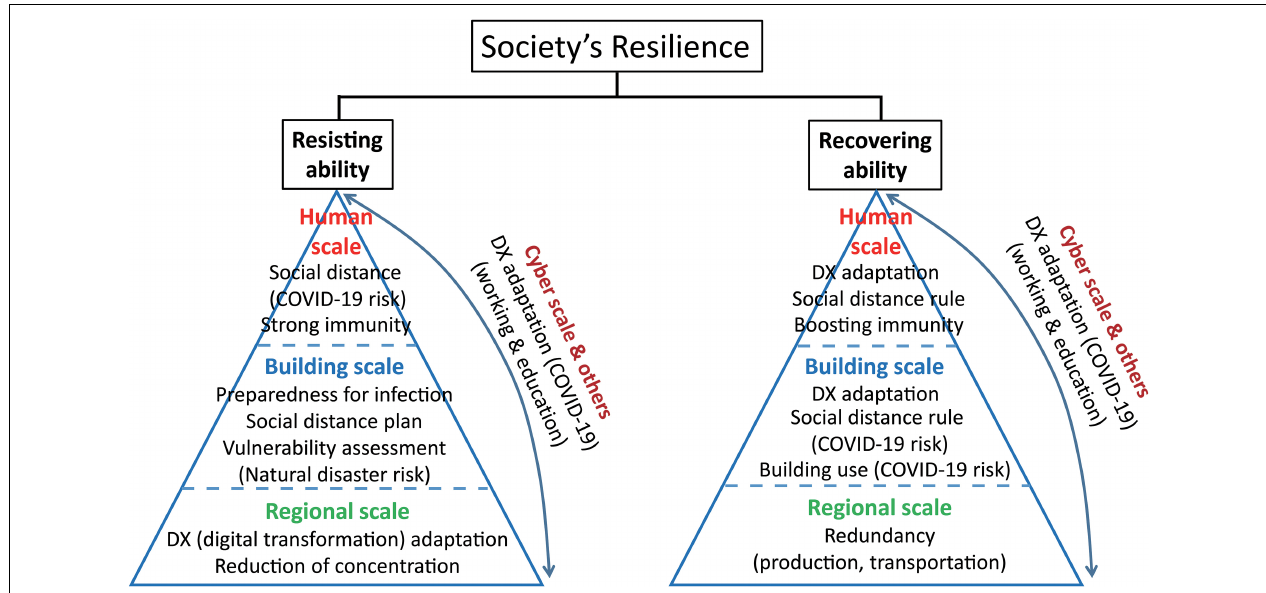
FIGURE 1 | New perspective in society’s resilience supported by resisting abilities (“plan, absorb”) and recovering abilities (“recover, adapt”) at human, building, regional, and cyber scales (Resilience Twin Pyramid).